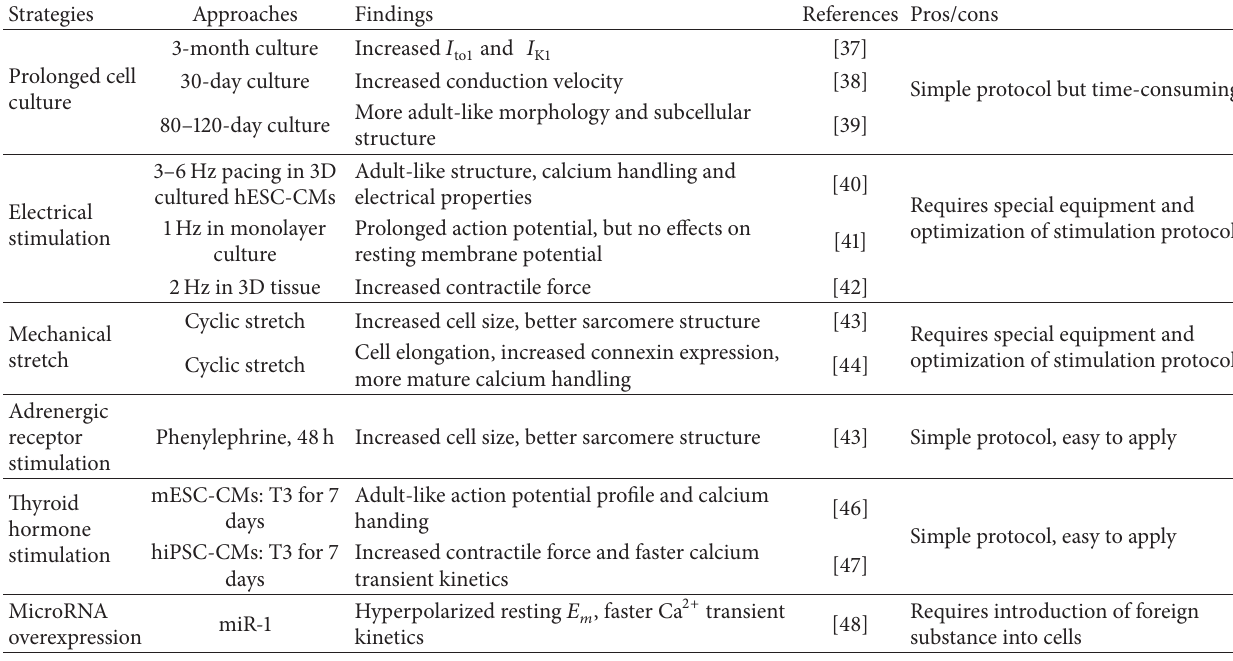
Table 1: Strategies to promote cardiomyocyte